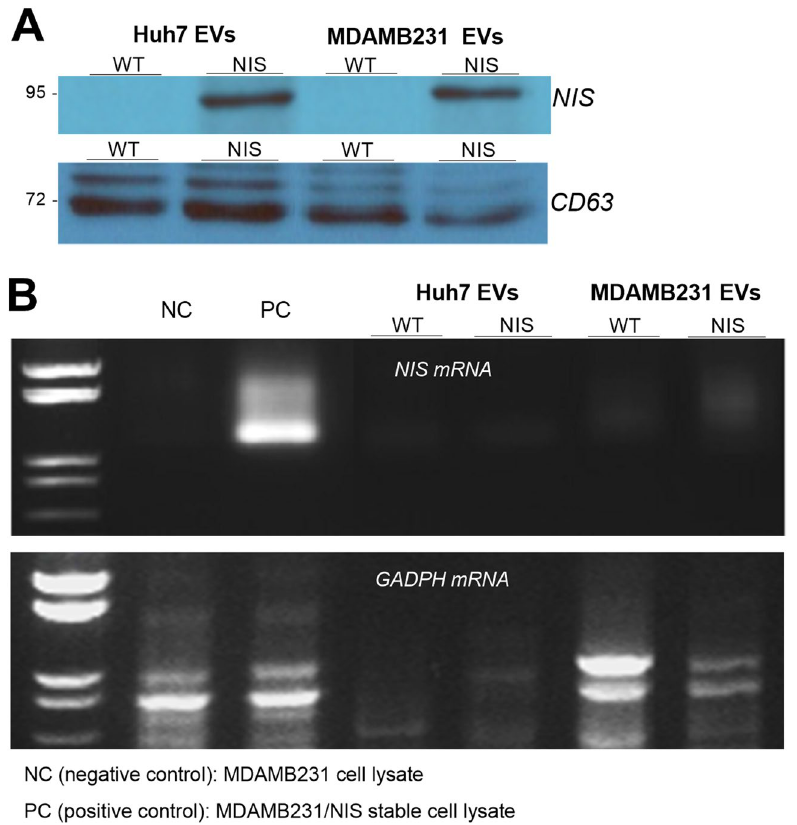
Figure 3. NIS protein and NIS mRNA in EVs from NIS-expressing cancer cells. ( A ) Western blots and quantified band intensities of NIS (top) and CD63 protein (bottom, control) in EVs derived from Huh7, Huh7/ NIS-Adv, MDAMB231, and MDAMB/NIS-stable donor cells. ( B ) RT-PCR for NIS mRNA (top) and GADPH mRNA (bottom, control) in EVs from respective donor cells. MDAMB231 and MDAMB231/NIS-stable cells were used for NIS mRNA negative control (NC) and positive control (PC),